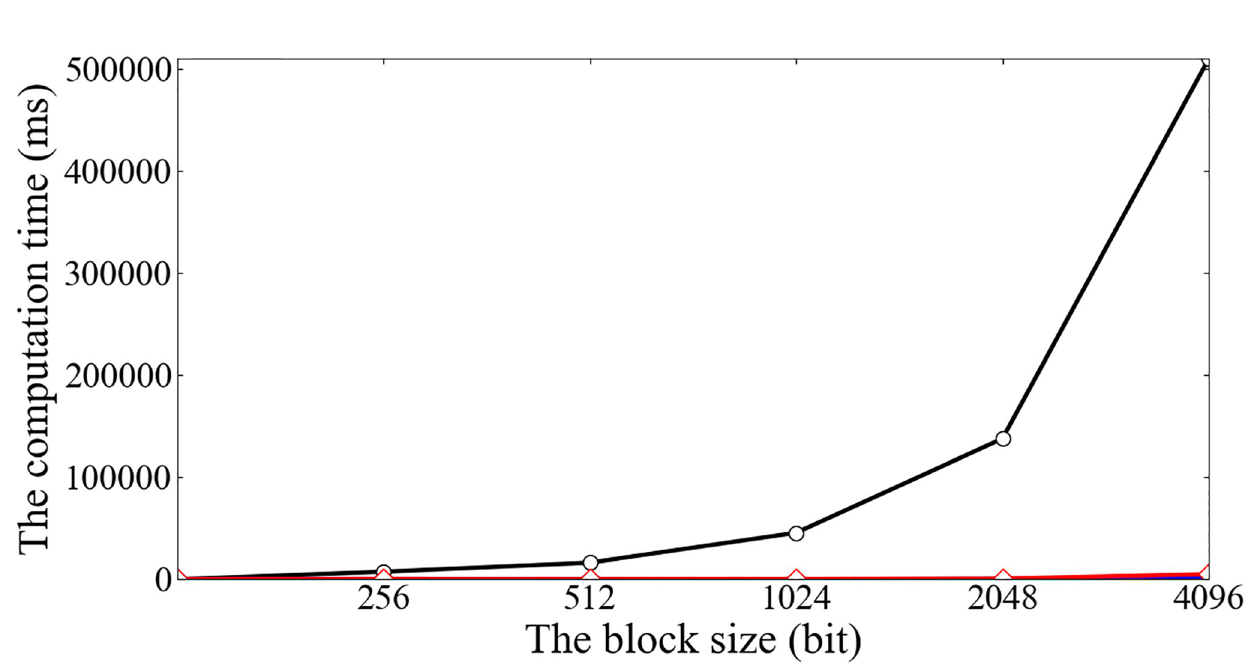
Fig 5. The computation cost for different block sizes.